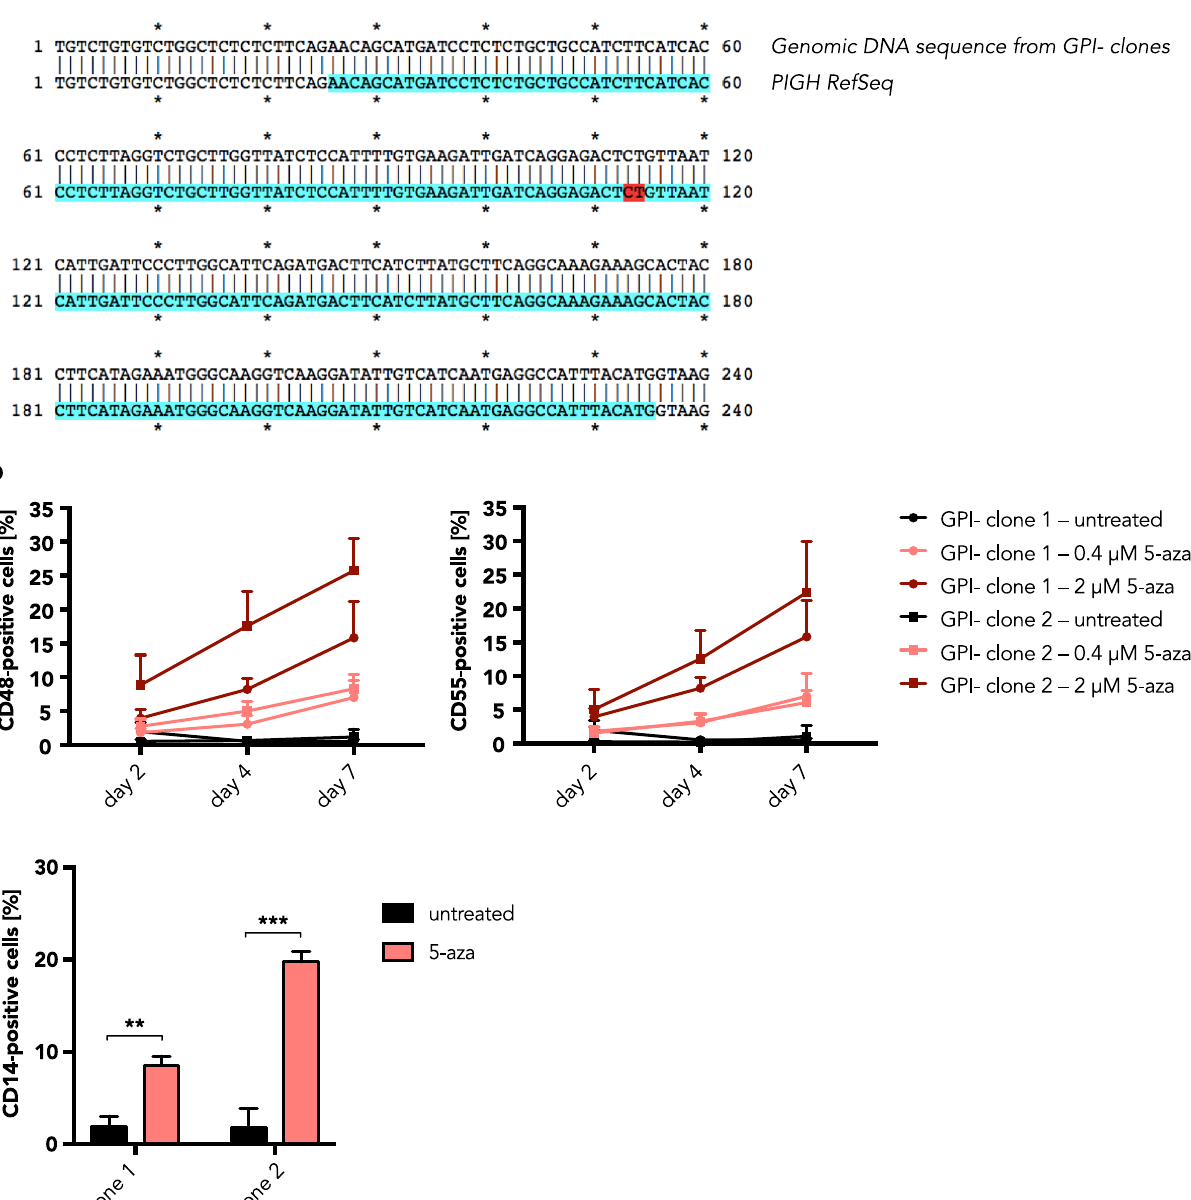
Since the original publication describing the establishment of the BLaER1 cell line 5 , an increasing number of studies have utilized BLaER1 monocytes, predominantly for the examination of inflammasome activation pathways. In most of these publications, CRISPR-Cas9 genome editing followed by single-cell isolation and